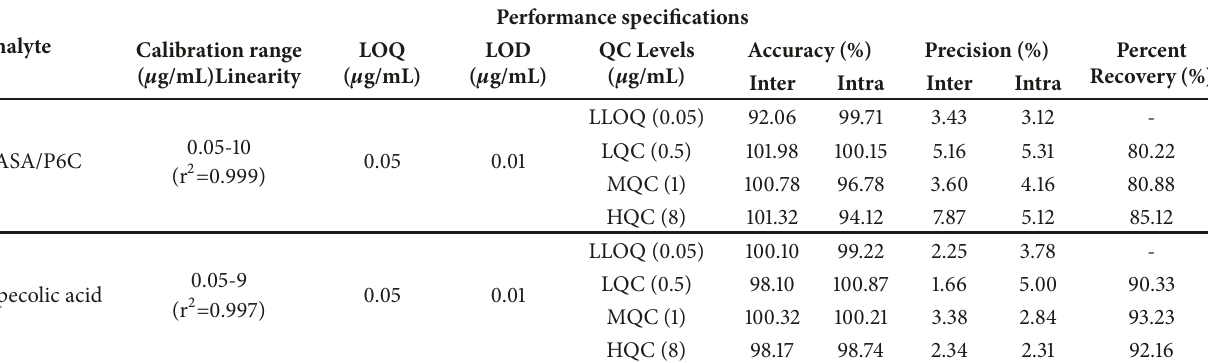
Table 1: Method performance specifications for AASA/P6C and pipecolic acid.